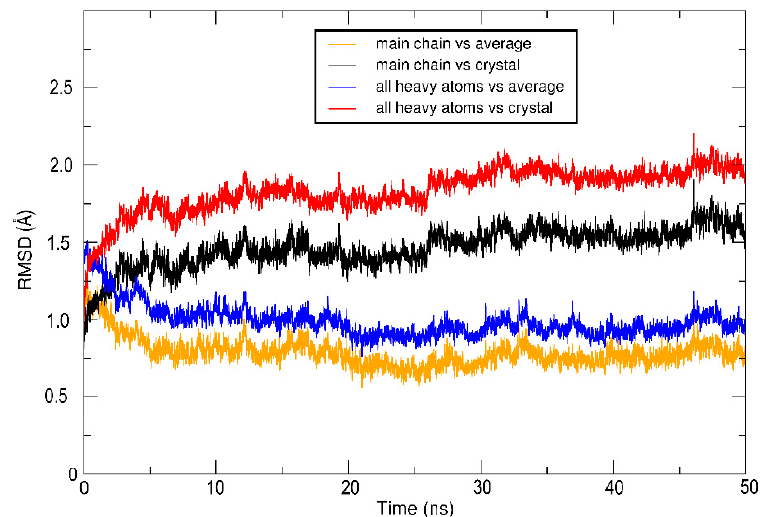
Figure 4. Molecular dynamics (MD) time series of root mean square deviation (RMSD) for LinB MD D147C+L177C at 300 K. RMSD of the protein main chain with respect to the MD average structure is shown in orange; the protein main chain with respect to the crystal structure is in black; RMSD of non-hydrogen atoms with respect to the MD average structure is in blue, and RMSD of non-hydrogen atoms with respect to the crystal structure is in red.